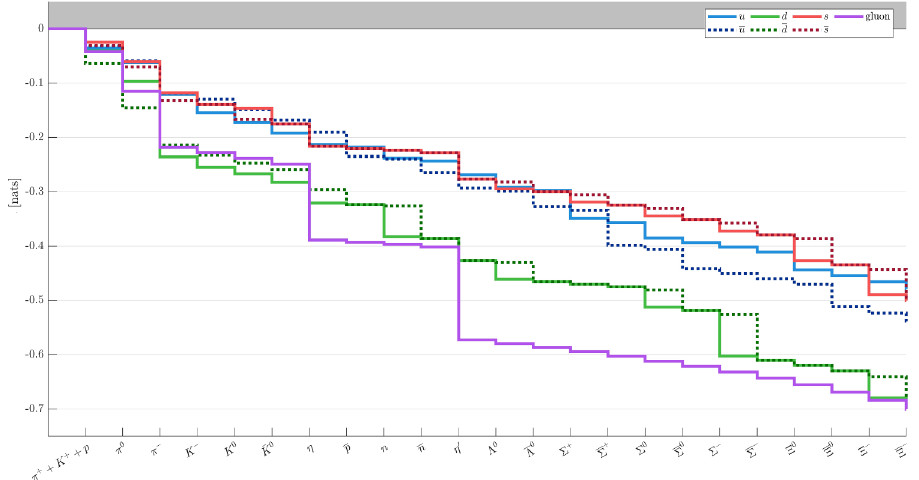
Figure 4. Simulated improvement on the upper bound on S as more fragmented hadrons are